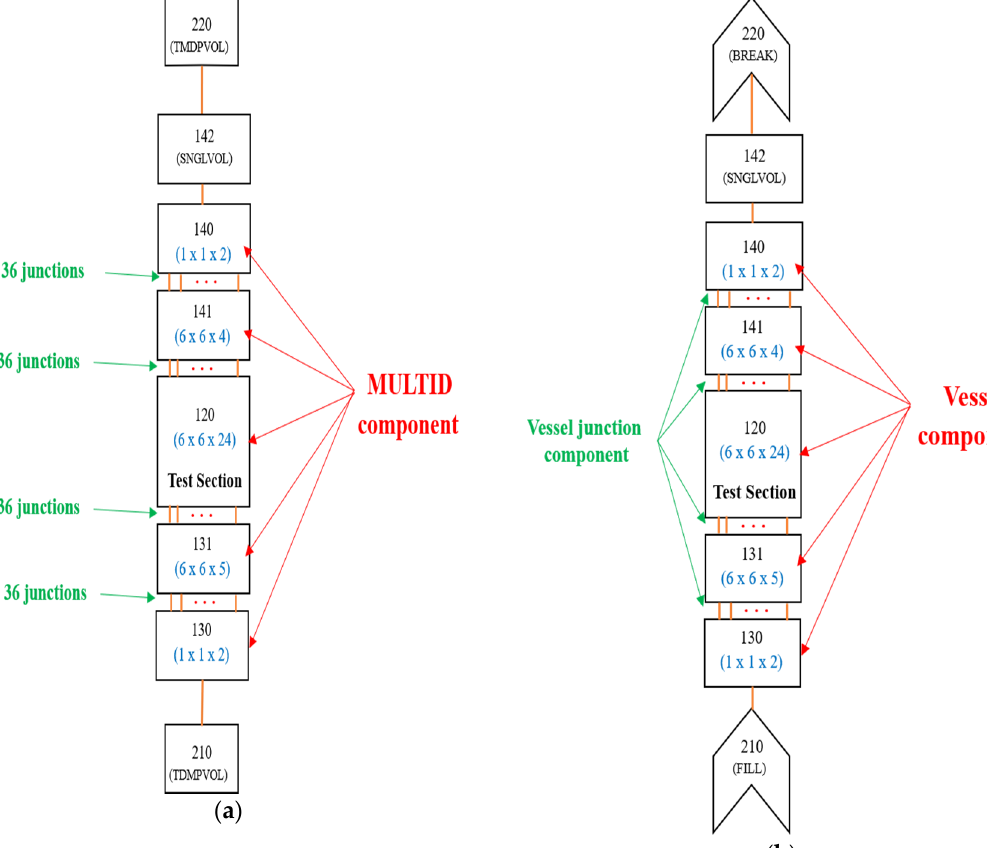
Figure 4. Nodalization scheme of multi-dimensional model of each system code: ( a ) multi-dimensional model of MARS-KS; ( b ) multi-dimensional model of TRACE.